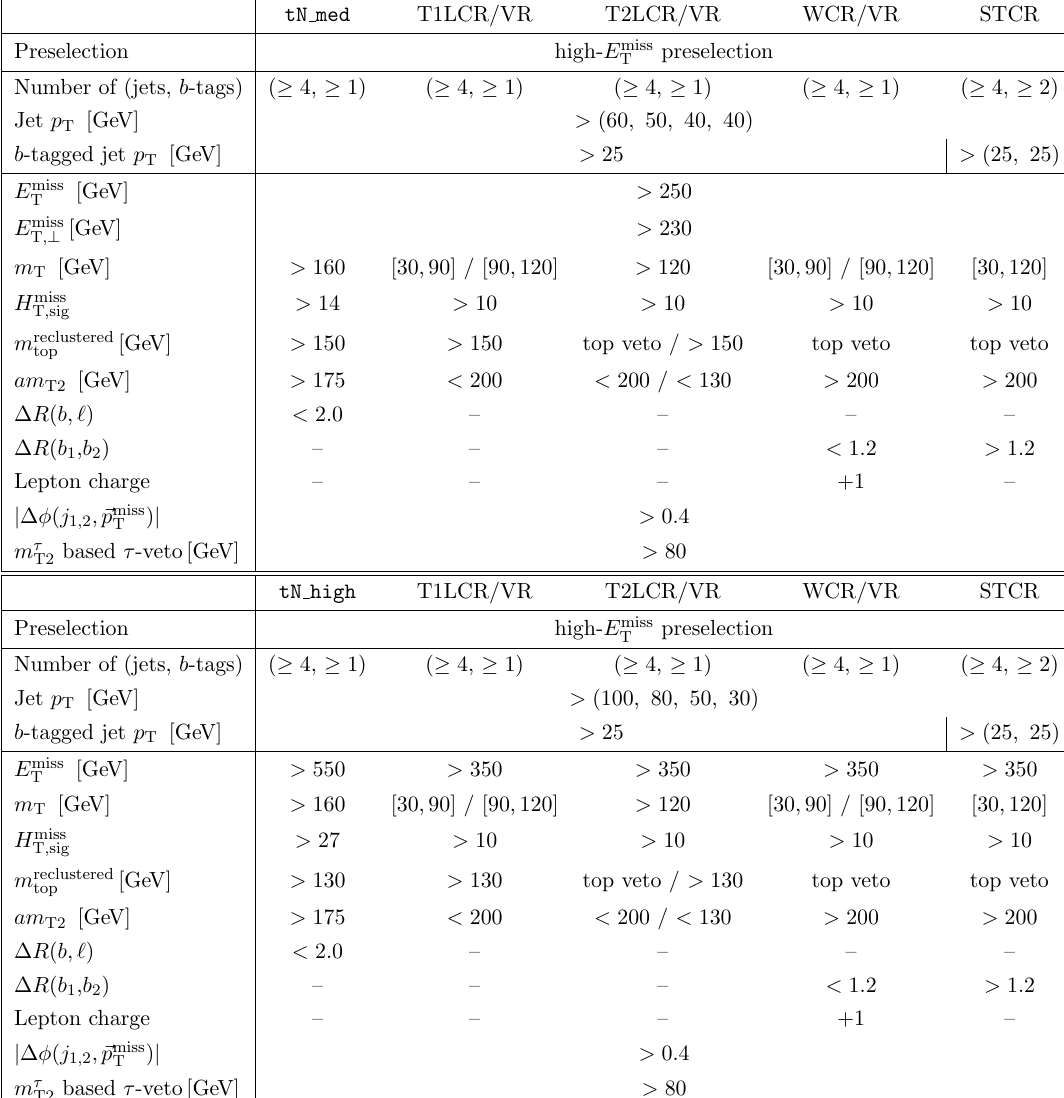
Table 13 . Overview of the selections for the tN med and tN high signal regions as well as the associated control and validation regions. The control regions include the semileptonic t (cid:22) t control region (T1LCR), the dileptonic t (cid:22) t control region (T2LCR), the W +jets control region (WCR), and the single-top Wt control region (STCR). The validation regions include the semileptonic t (cid:22) t validation region (T1LVR), the dileptonic t (cid:22) t validation region (T2LVR), and the W +jets validation region (WVR). List values are provided in between parentheses and square brackets denote intervals. The veto on the reclustered hadronic top-quark candidate is satis(cid:12)ed for events where no reclustered jet candidate is found, or where the mass of the hadronic top-quark candidate ( m reclustered ) is below top the speci(cid:12)ed tag threshold. For the WCR, (cid:1) R ( b 1 , b 2 ) < 1 : 2 is not required when the event has only one b -tagged jet. The selection of the t (cid:22) t + V control region (TZCR) is detailed in section